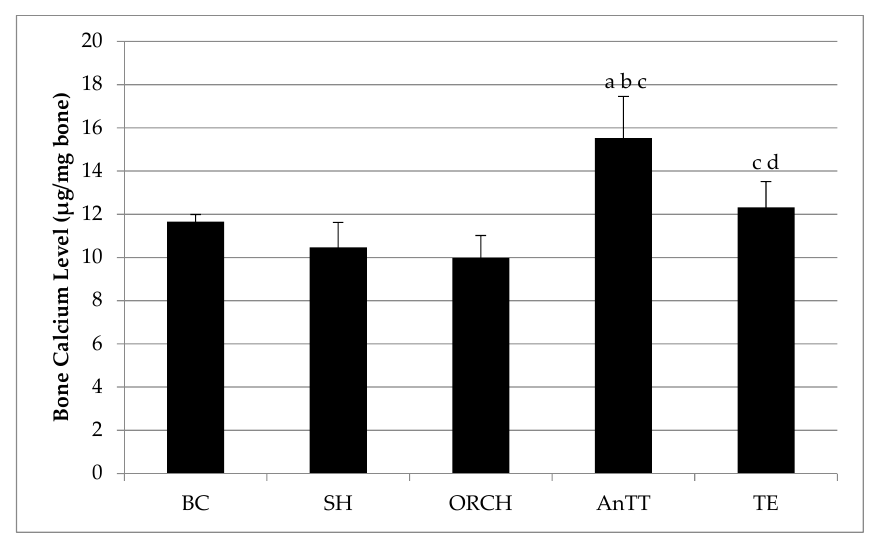
Figure 4. Post ‐ treatment bone calcium level in rats. The data are shown as mean with standard error of the mean. Letter ‘a’ indicates significant difference versus the baseline group; ‘b’ versus the sham ‐ operated group; ‘c’ versus the orchidectomized group; ‘d’ versus the annatto tocotrienol ‐ supplemented group. Abbreviation: AnTT, annatto tocotrienol ‐ supplemented group; BC, baseline control group; ORCH, orchidectomized group; SH, sham ‐ operated; TE, testosterone enanthate ‐ supplemented group.